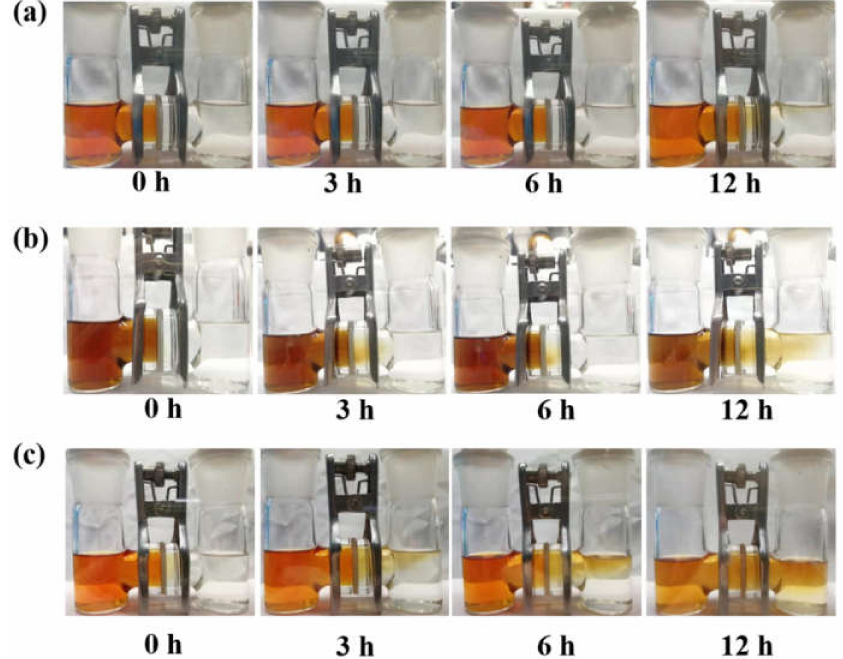
Figure 5. The sieving effect experiment: H-tube permeation test with different separators: ( a ) ATFG- COF/PP, ( b ) AB-COF/PP, and ( c )